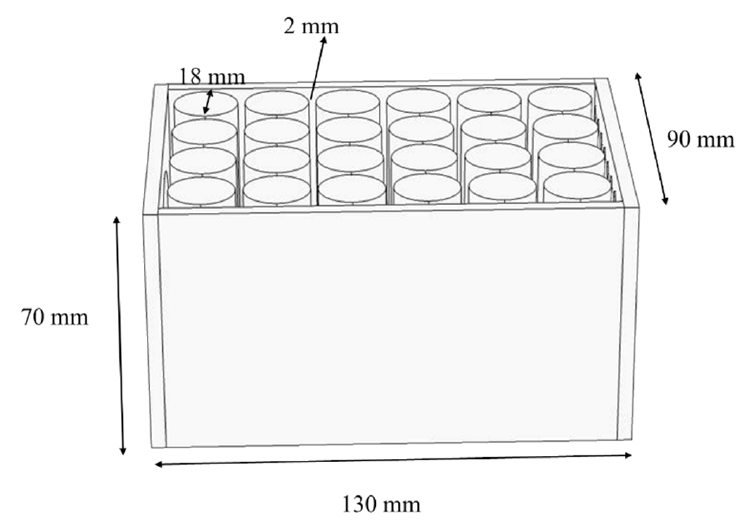
Figure 1. Schematic of the battery module with dimensions.